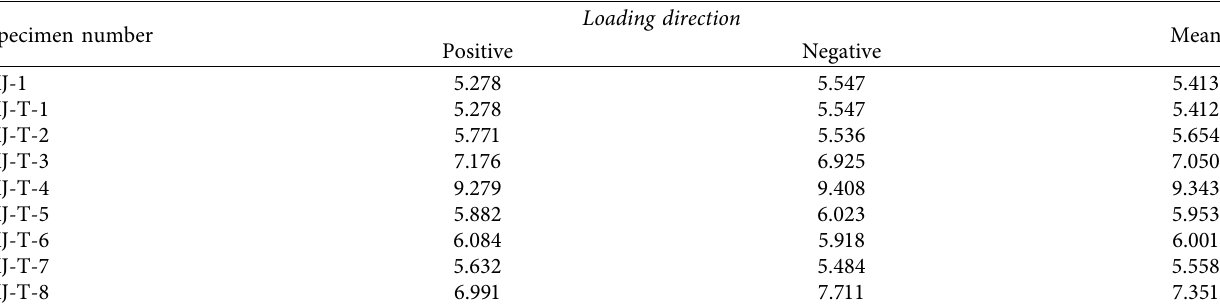
Figure 15: Stiffness degradation. (a) /e effect of opening rate. (b) /e effect of the infill falls position. (c) /e effect of the block strength. Table 6: Displacement ductility